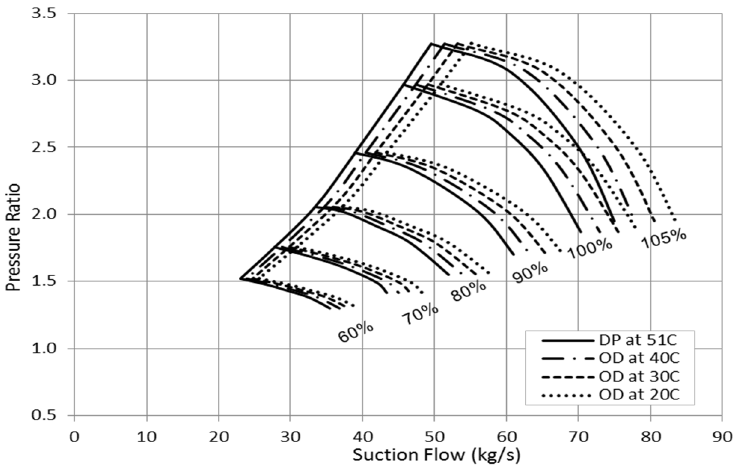
Figure 7. Effect of suction temperature on the compressor pressure